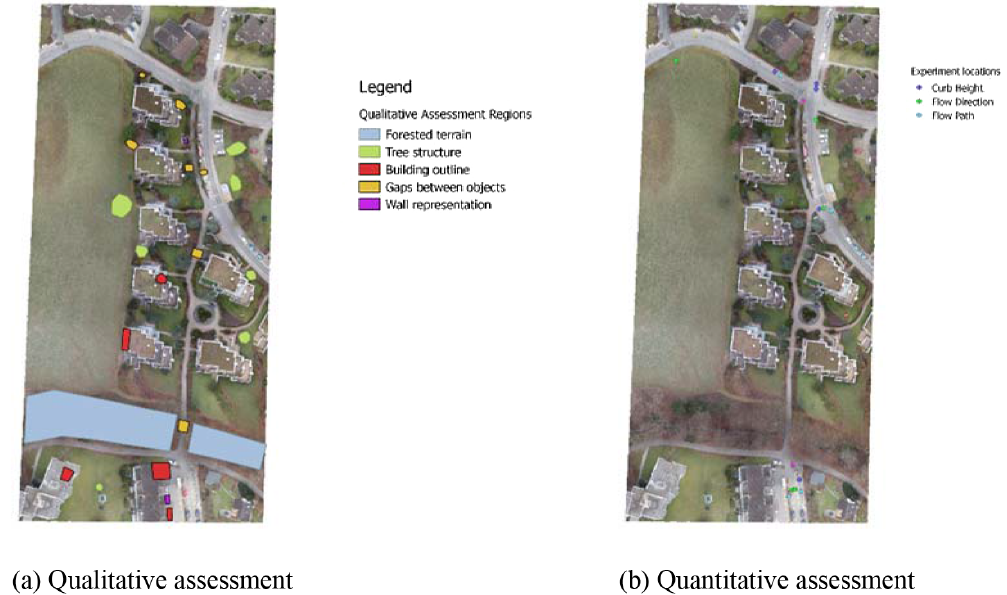
Figure 4. Location used to calculate the metric